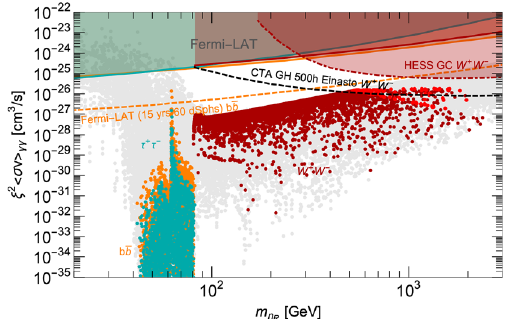
Fig. 6 Predicted η R annihilation cross section into γ rays – weighted bytherelativeabundance–forannihilationsto b ¯ b (orange), τ + τ − (dark cyan)and W + W − (darkandlightred)finalstates.Theorange,darkcyan anddarkredplainlinesrefertothecorresponding95%C.L.upperlimits currently set by the Fermi-LAT with γ -ray observations of dSphs [64]. The dark red dot-dashed curve is the current upper limit obtained by H.E.S.S. using GC data [65]. We also compare with sensitivity projec- tions for Fermi-LAT ( b ¯ b , 60 dSphs and 15 years of data) [66] and for CTA (GC, W + W − ) [67]. See text for more